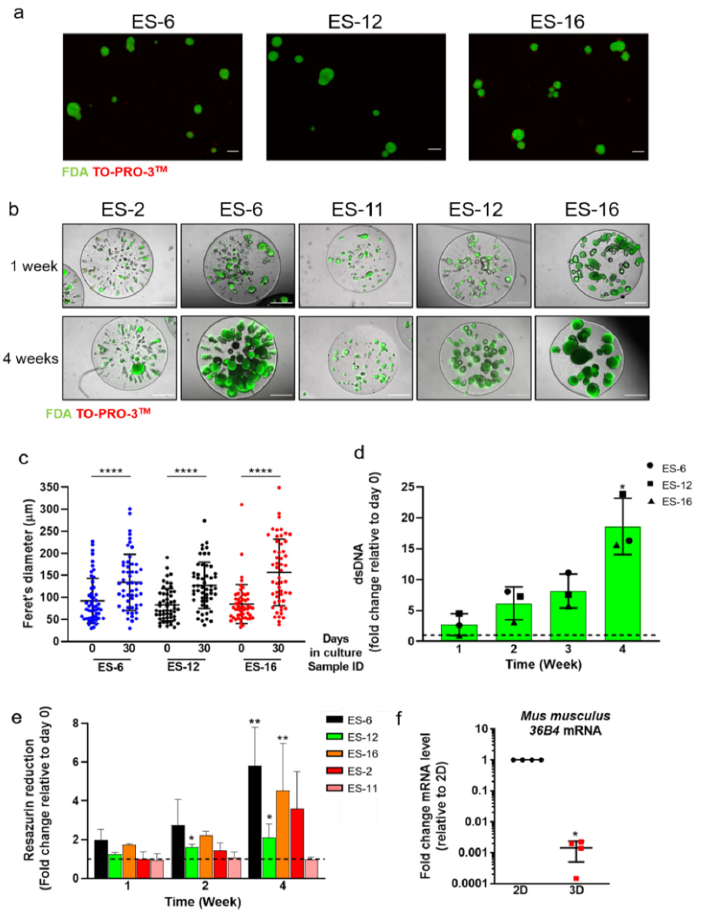
Figure 1. Cell viability and proliferation in encapsulated Ewing’s Sarcoma (ES) spheroid cultures. ( a ) ES spheroids formed from single cell suspensions of three distinct ES patient-derived xenografts (PDX); live cells: FDA; dead cells: TO-PRO-3 TM . Scale bar: 100 µ m. ( b ) Representative images